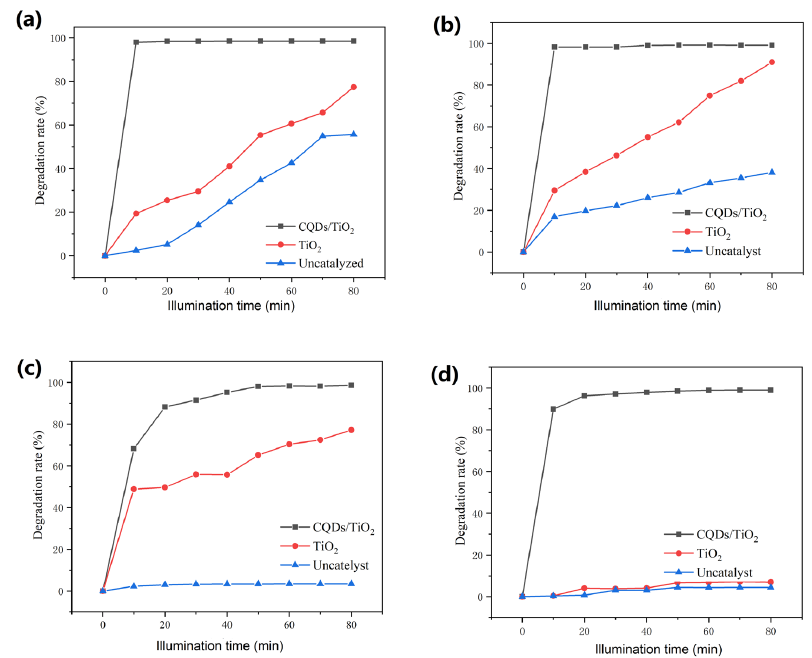
Figure 9. The photocatalytic degradation rate of CQDs/TiO 2 composite and pure TiO 2 to malachite green ( a ) methyl violet ( b ), basic fuchsin ( c ), and rhodamine B ( d ) within different irradiation times under 405 nm purple light. Table 7. The kinetic adsorption parameters obtained using pseudo-first-order for the photocatalytic degradation of various dyes under 405 nm purple light.